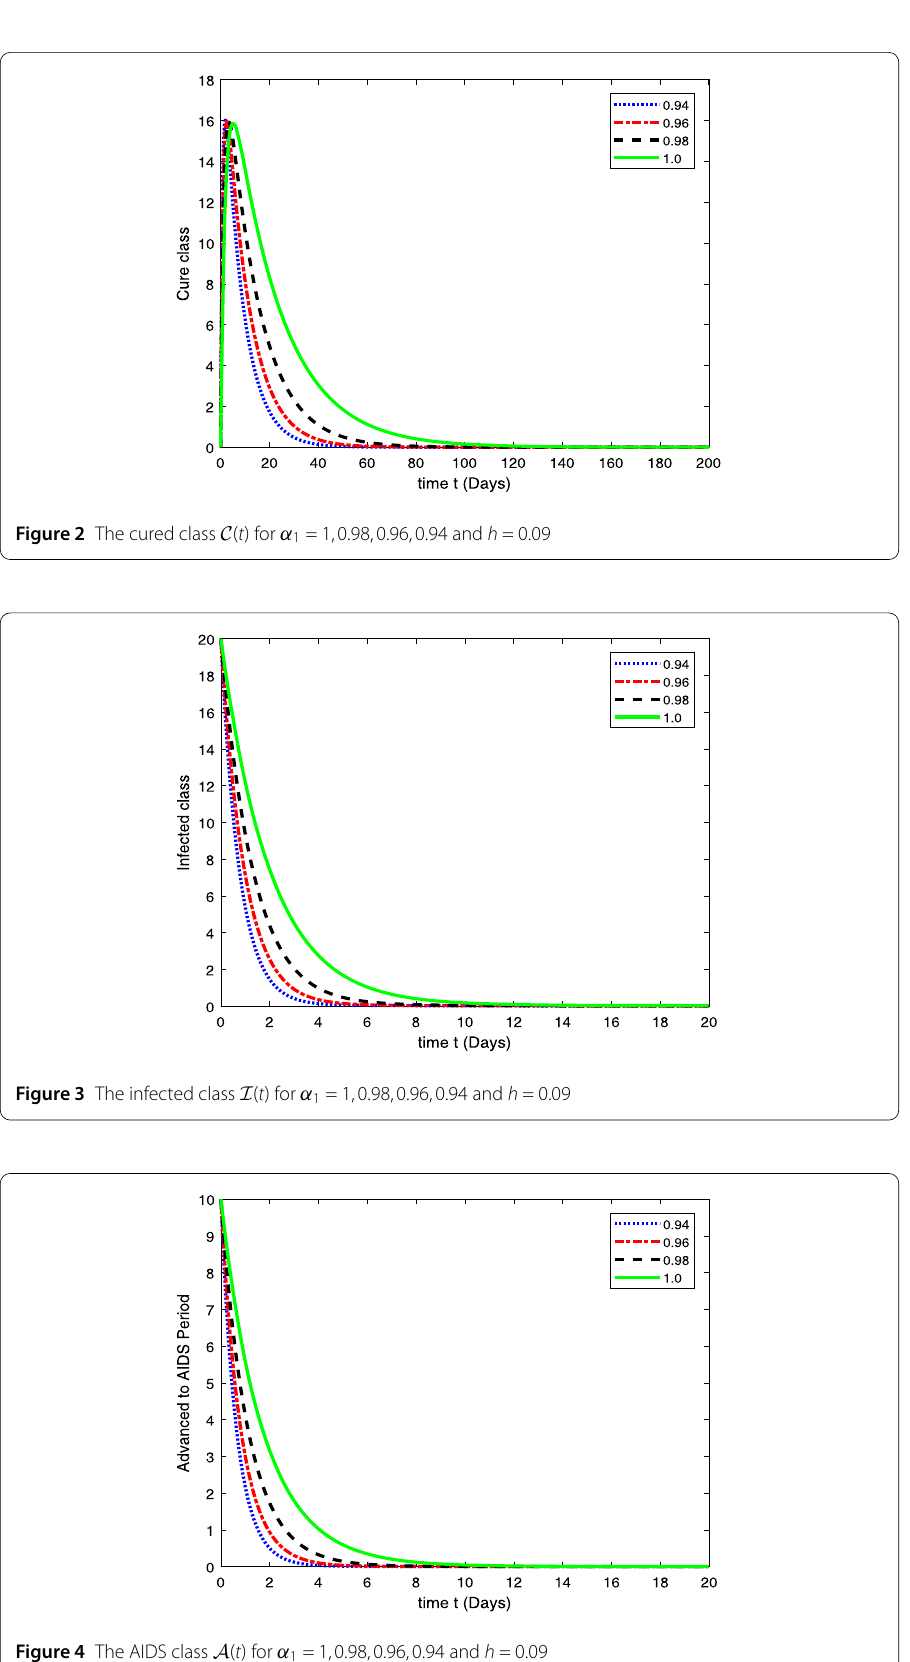
Figure 4 The AIDS class A ( t ) for α 1 = 1,0.98,0.96,0.94 and h =